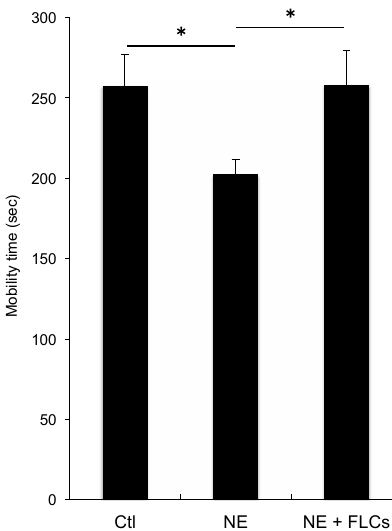
Figure 4. Analysis of motility time in 6 min at 4 weeks after the NE administration with or without FLCs transfer. * p < 0.05, n = 6 for each. NE: neutrophil elastase, FLCs: fetal lung cells.